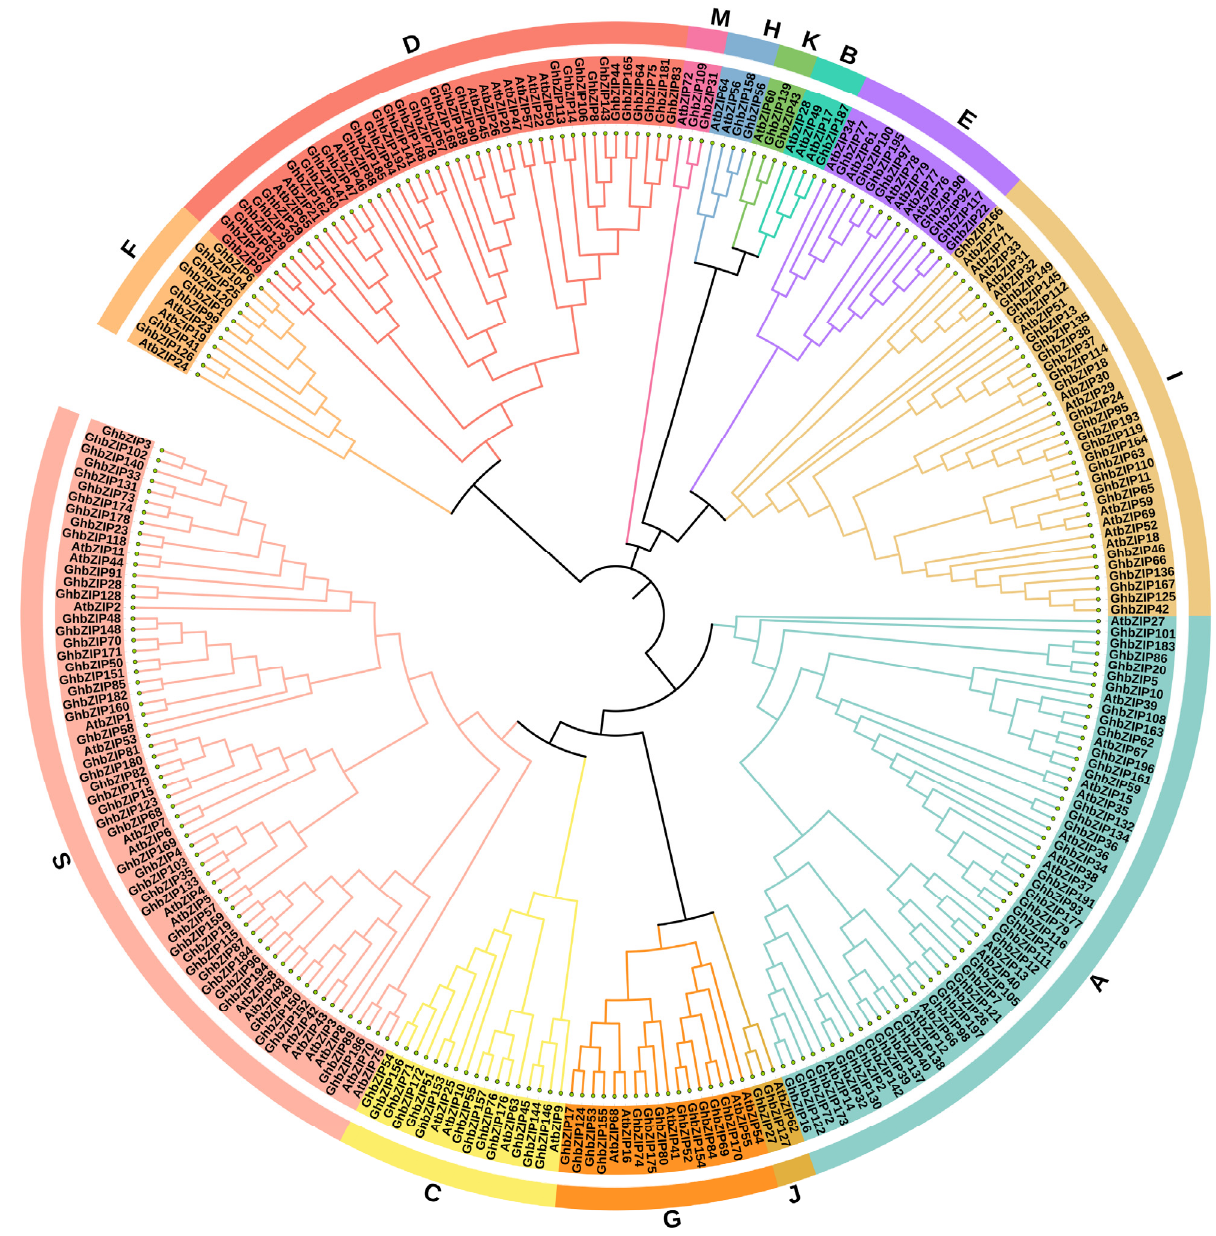
Figure 3. Phylogenetic analysis and subgroup classification of GhbZIP proteins. The phylogenetic tree of bZIP proteins was performed on the basis of similarities in the conserved bZIP domains and the homologues proteins in Arabidopsis. The 197 bZIP proteins (bZIP1 to bZIP197) were classified into 13 groups (A through K, M, and S), following the generic naming according to their position on chromosomes.